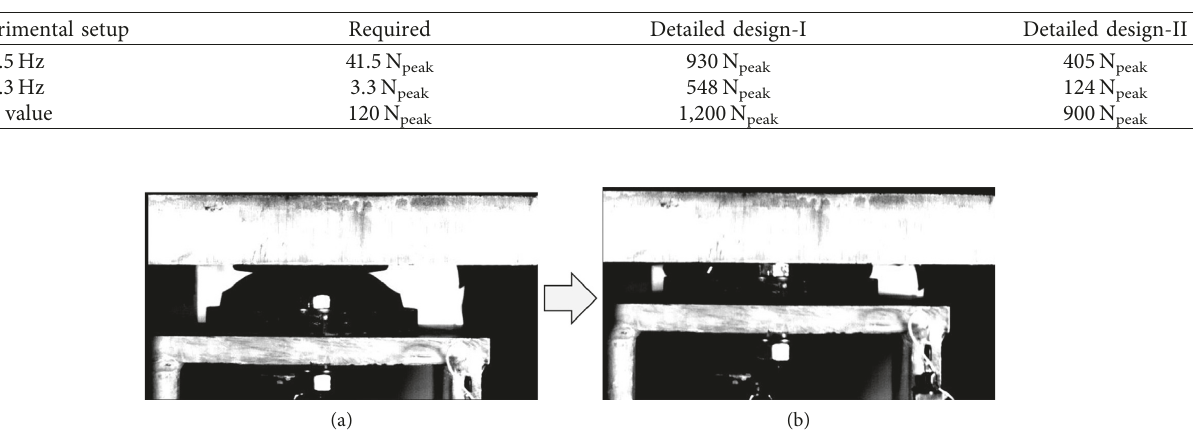
Figure 8: Maximum deflection of passive rubber mount applying required shock based on MIL-S-901D. (a) Equilibrium state. (b) Maximum deflection.